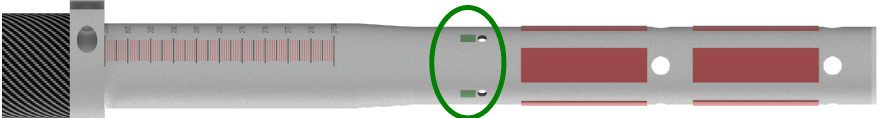
Figure 2. CAD rendering of handle unit with the surface pressure sensors (red) and strain gauges (green) mounted on a Concept 2 scull.